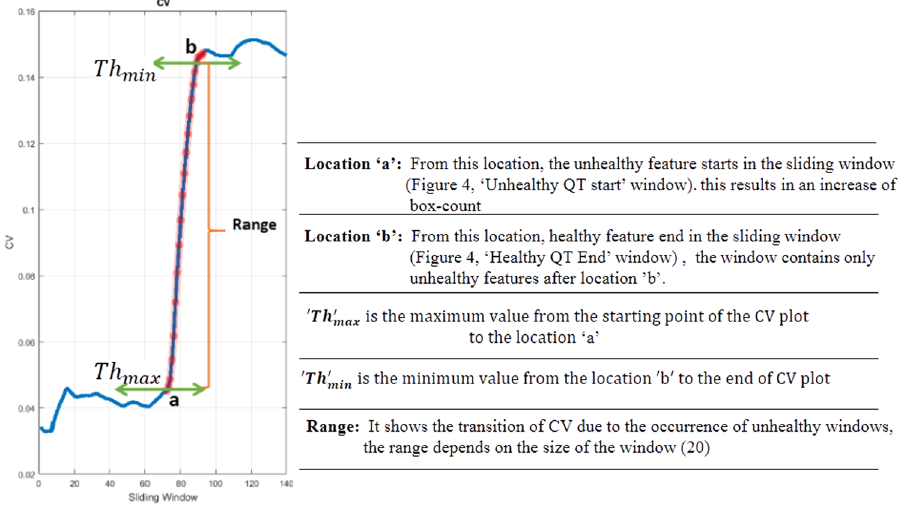
Figure 3. Coefficient Variation of single